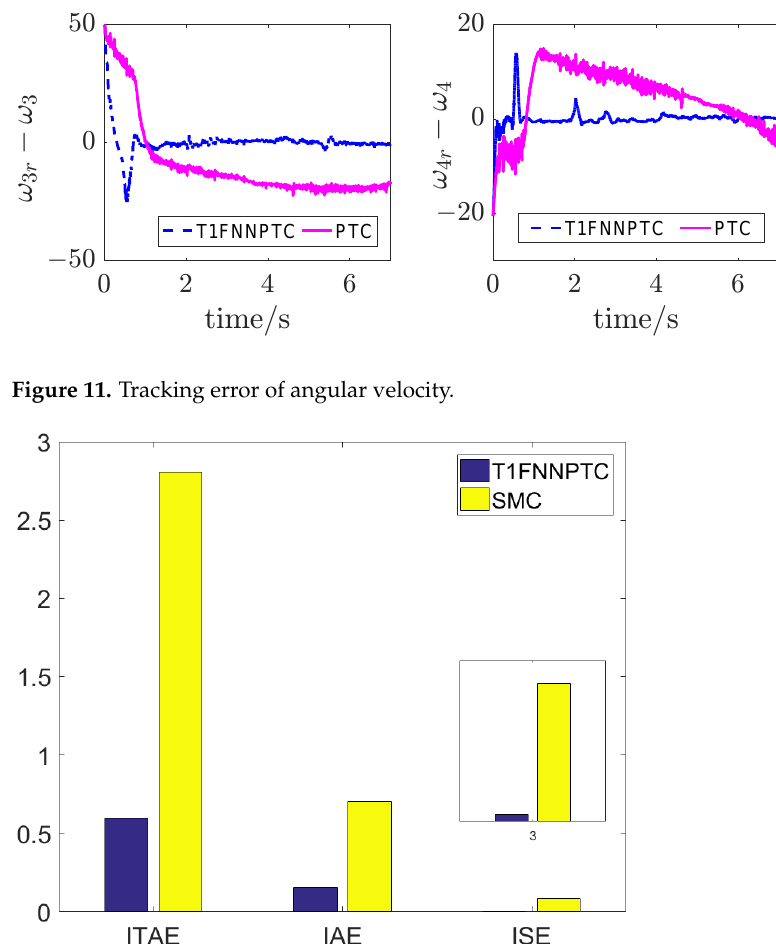
Figure 12. Error